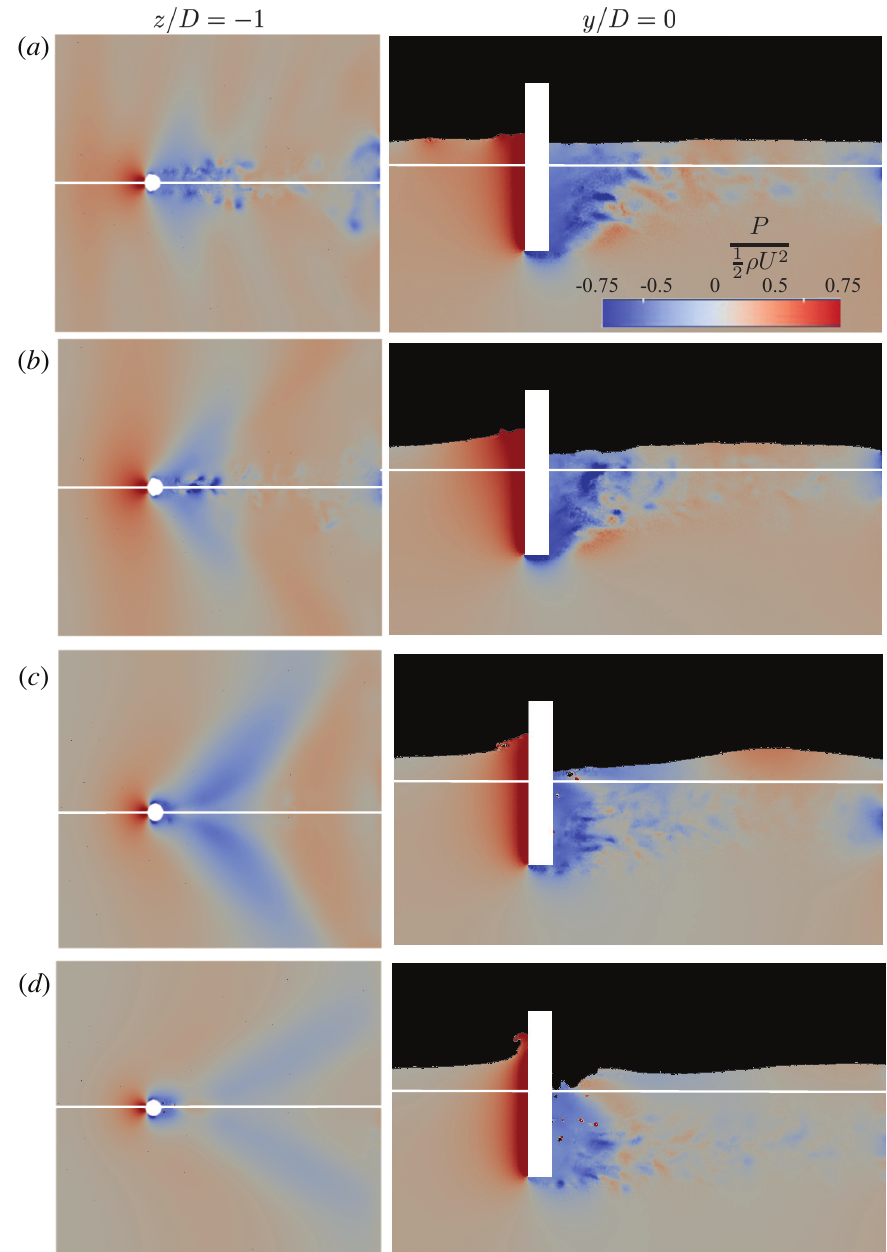
Figure 2. Instantaneous dimensionless pressure fields at Ut / D = 60 for D = 5 cm. ( a ) Re = 30,000, Fr = 0.86; ( b ) Re = 45,000, Fr = 1.28; ( c ) Re = 55,000, Fr = 1.57; and ( d ) Re = 70,000, Fr = 2. The white line in the horizontal planes, z / D = − 1, indicates the vertical plane. In the the vertical planes, y / D = 0, the white line represents the horizontal